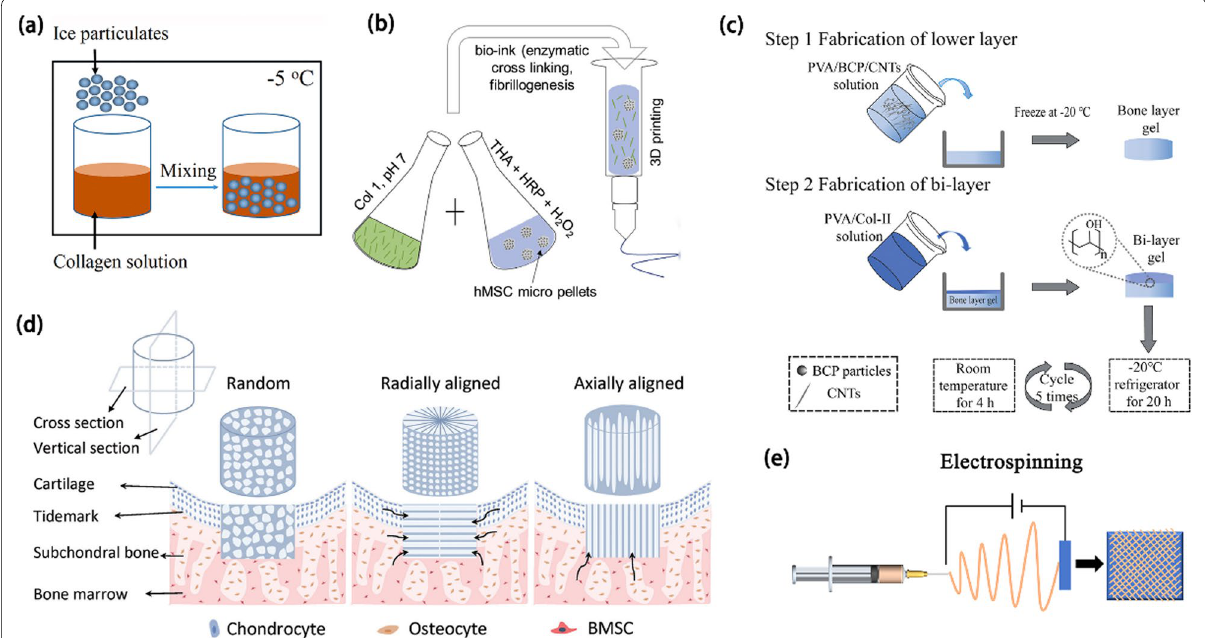
Fig. 3 Novel forming technologies of collagen-based biomaterials. a Ice particle for pore-forming. Ice particle in specific size was used as a pore-forming agent to develop collagen scaffold with controlled pore structure before freeze-drying. (Adapted from ref. [80], copyright 2020, with permission from Elsevier.) b Three-dimensional (3D) printing forming technology. 3D printing was employed to fabricate bio-matrix containing collagen type I (COL I), tyramine derivative of hyaluronan (THA) and human bone marrow–derived mesenchymal stromal cell (hMSC), while horseradish peroxidase was the cross-linking agent for THA. (Adapted from ref. [84], copyright 2020, with permission from Elsevier.) c Combination of sequential freeze, freeze thawing and freeze-drying to prepare bilayer scaffold. PVA, BCP, CNTS and Col II represent Polyvinyl alcohol, biphasic calcium phosphate, carbon nanotubes and collagen type II, respectively. (Adapted from ref. [79], copyright 2021, with permission from Elsevier.) d The oriented architecture of collagen-based scaffolds by sequential unidirectional freezing method with random pores, radially aligned pores and axially aligned pores. (Adapted from ref. [82], copyright 2020, with permission from Royal Society of Chemistry.) e Collagen-based nanofibrous membrane formed by